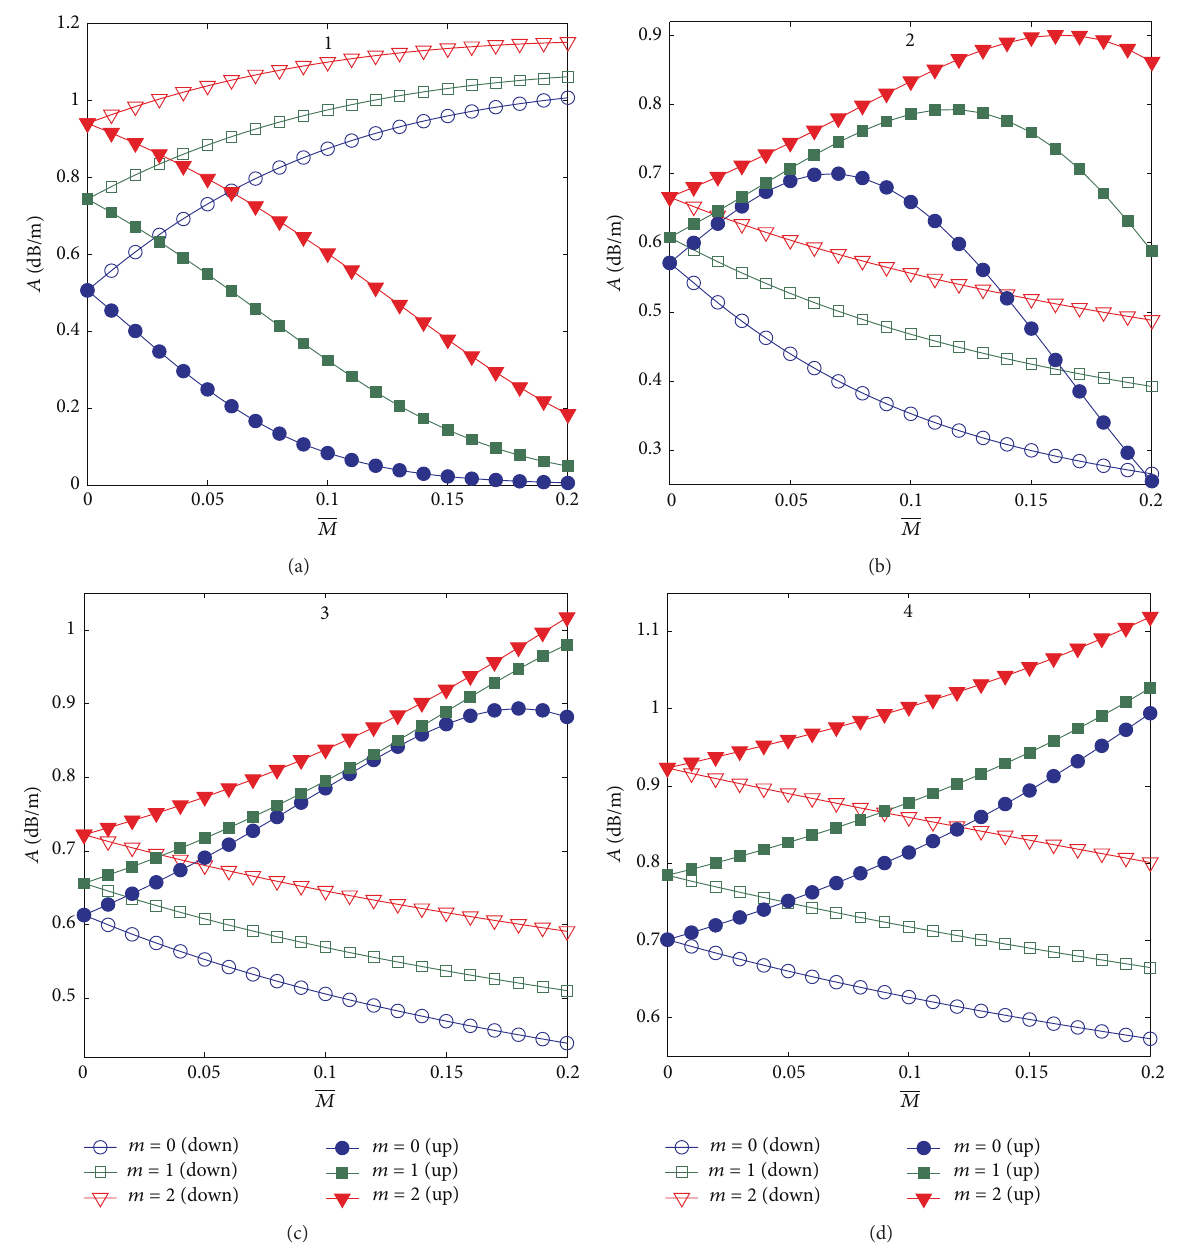
Figure 8: (Color online) Comparison of the attenuation coefficients of the first four axial pseudo-modes among the three circumferential modes in the turbulent flow confined by a lined-walled